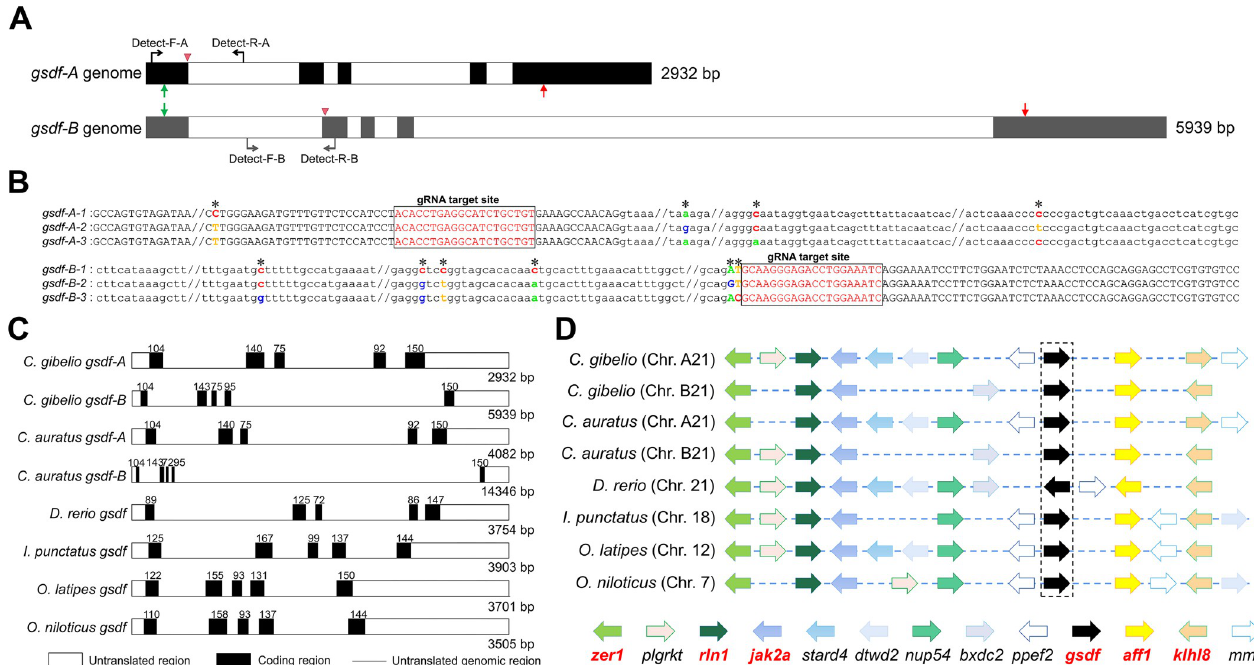
Fig 1. Characterization of gsdf-A and gsdf-B in hexaploid gibel carp. (A) Genomic sequence diagram of two divergent gsdf homeologs including gsdf-A and gsdf-B . The black boxes indicate exons while the white boxes represent introns. Initiation codon and termination codon are marked by green and red arrows, respectively. The primer pairs used to distinguish different alleles and to examine mutant genotypes are indicated by black arrows. Red arrow heads indicate the target sites of guide RNAs (gRNA) used for knockout experiment with CRISPR/Cas9. (B) Fragments of three gsdf-A alleles amplified by primer pair of Detect- F-A and Detect-R-A, and fragments of three gsdf-B alleles amplified by primer pair of Detect-F-B and Detect-R-B. The asterisks indicate SNPs used for distinguishing different alleles. The red sequences in black box display the target sequences of guide RNAs. (C) Genomic structure of gsdf genes among different fish species. Exons and introns are depicted by rectangle boxes and thick lines, respectively. Lengths are exhibited by base pairs (bp). (D) Gene synteny of chromosomal fragments containing gsdf genes. Chromosome numbers are displayed at the left side. Conserved gene blocks are represented in matching colors. Transcription orientations are indicated by arrows. The genes marked in red color are conserved genes across all the analyzed species.